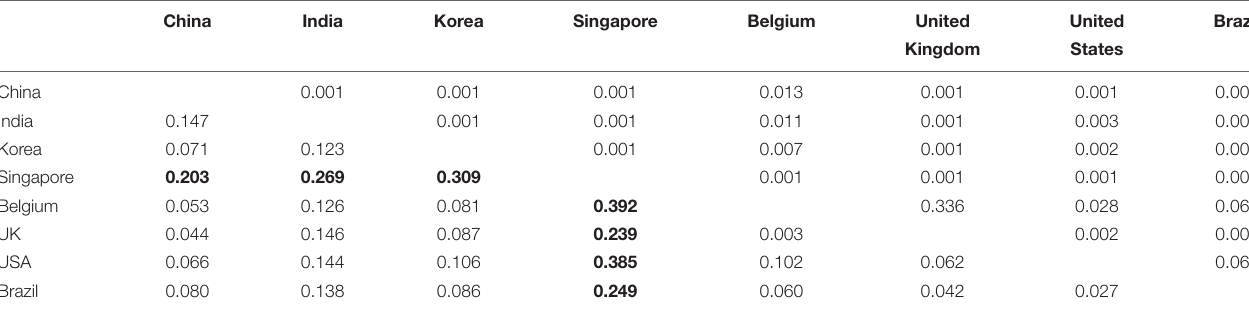
TABLE 5 | Genetic differentiation between pairs of geographic populations of C. tropicalis from different countries.